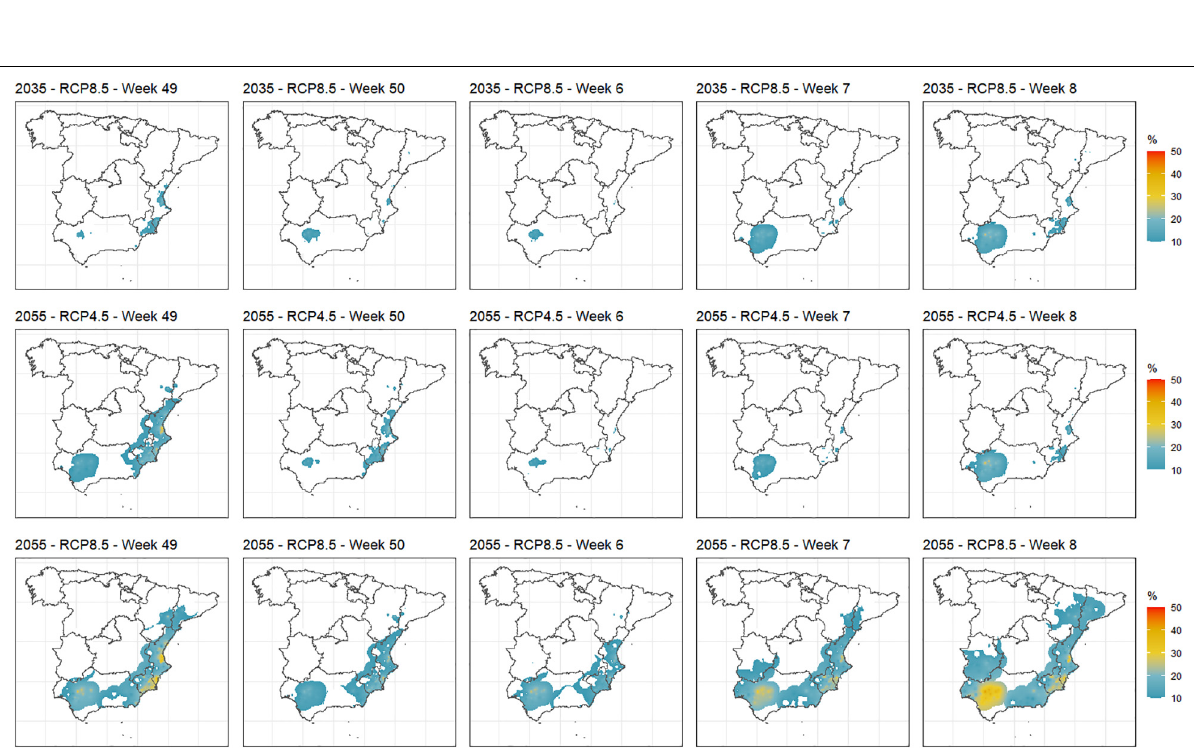
Frontiers in Plant Science |